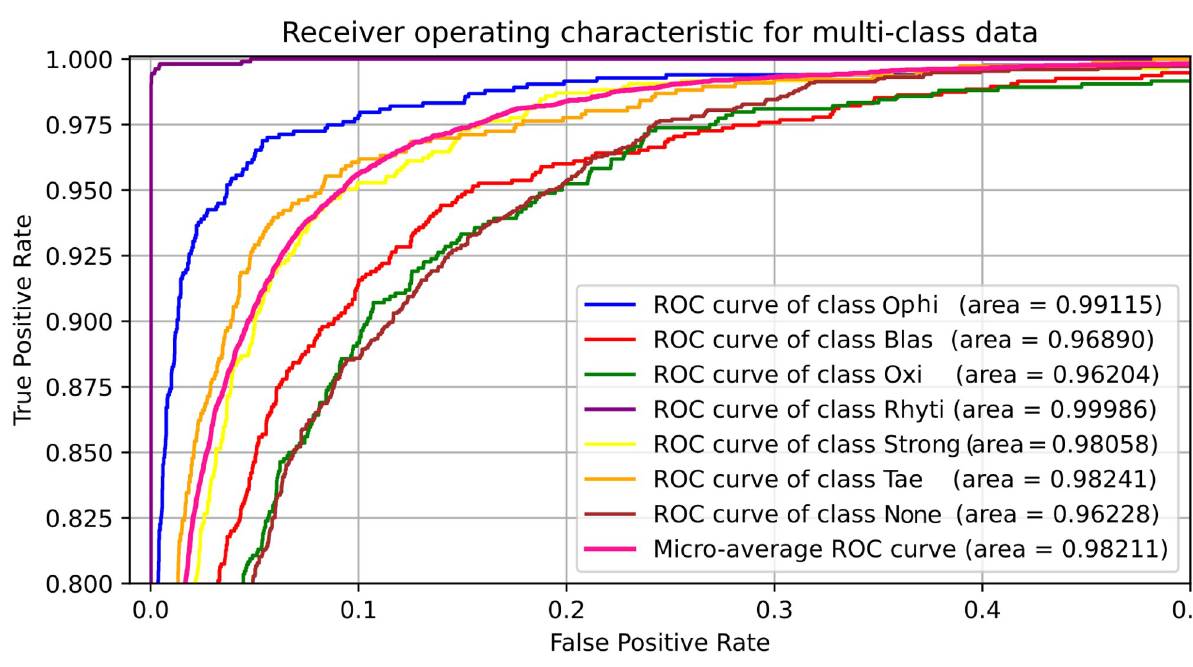
Fig 11. ROC plot for the optimized custom CNN.